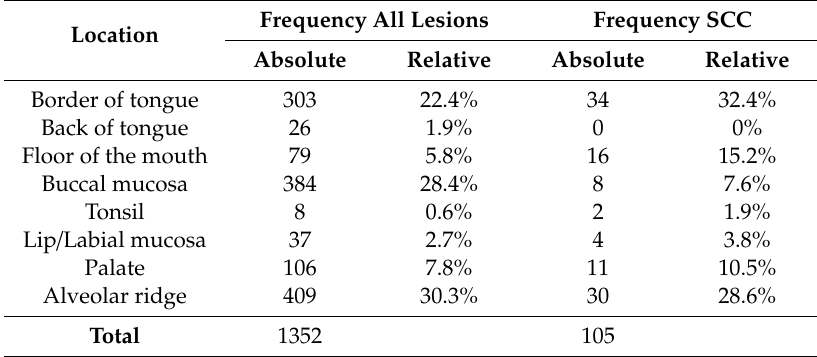
Table 3. Location of all lesions and squamous cell carcinomas (SCCs) and their